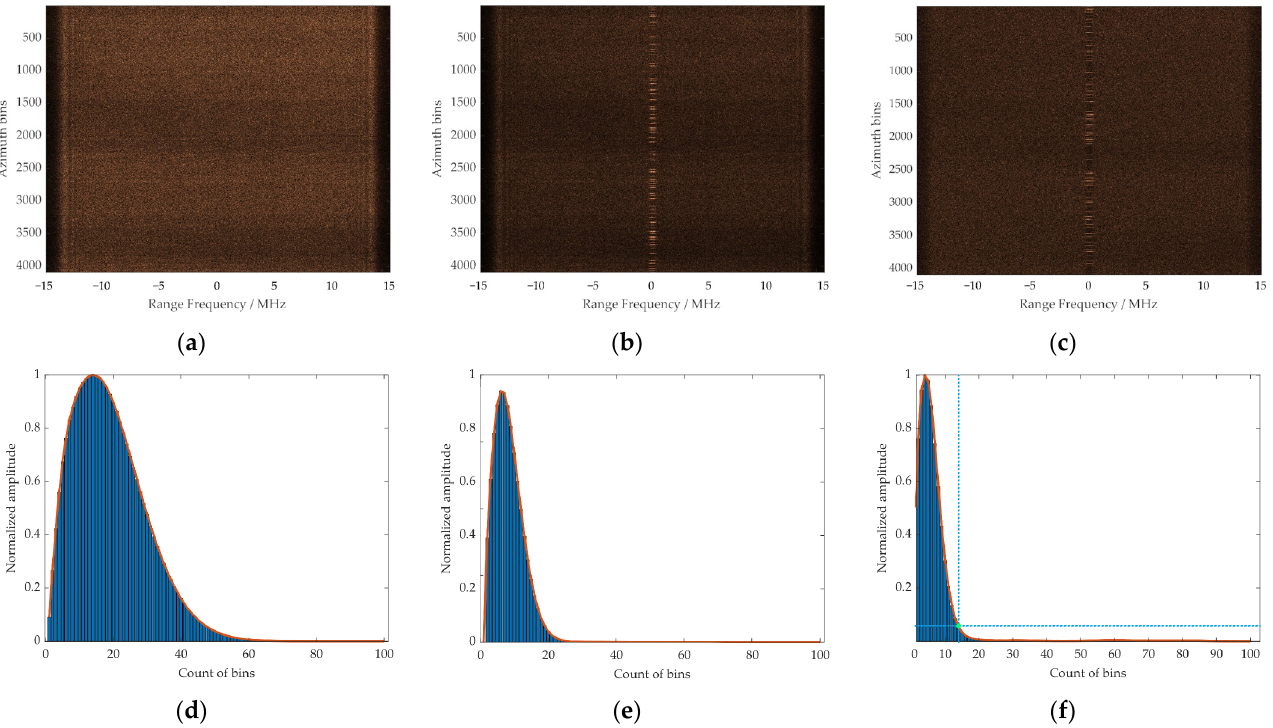
Figure 3. Statistical analysis of SAR range frequency spectrogram: ( a ) RFI-free signal; ( b ) RFI-containing signal; ( c ) Extraction of RFI; and ( d – f ) The amplitude histograms correspond to ( a – c ), respectively.